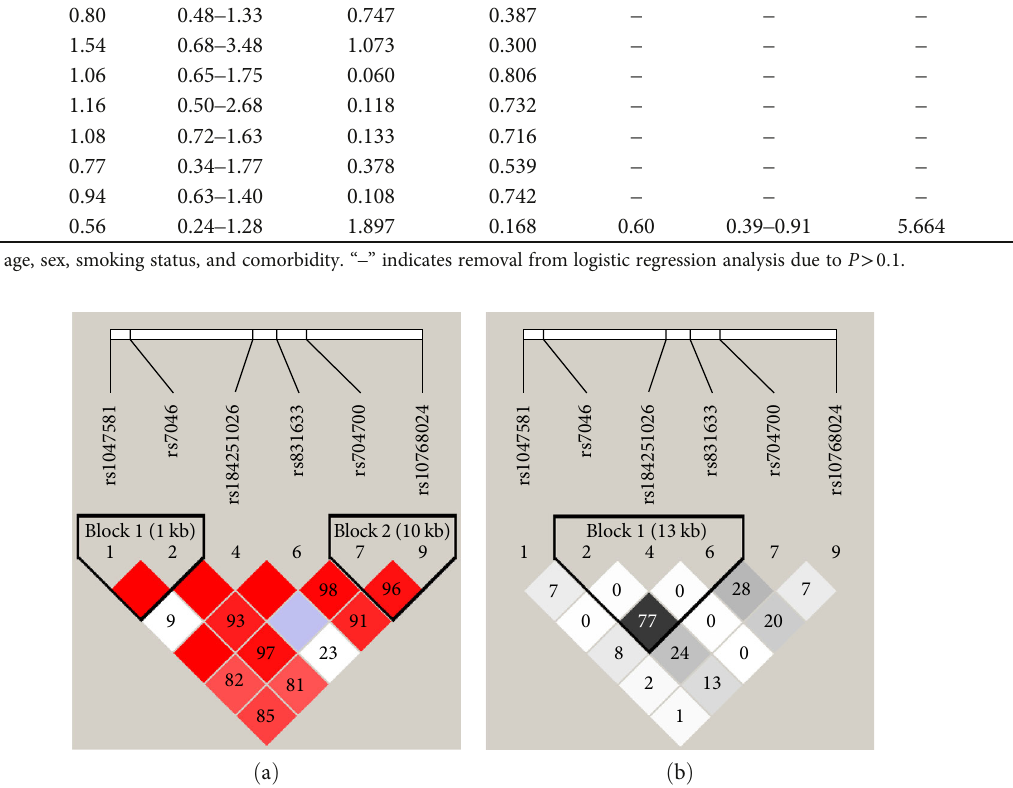
F IGURE 2: Linkage disequilibrium plot for the SNPs of CD59 gene. Note: (a) linkage disequilibrium decision with D ′ value; (b) linkage disequilibrium decision with r 2 value. Results showed that rs10768024 genetic mutation was almost no linkage disequilibrium with the other SNPs ( r 2 = 0.00 –